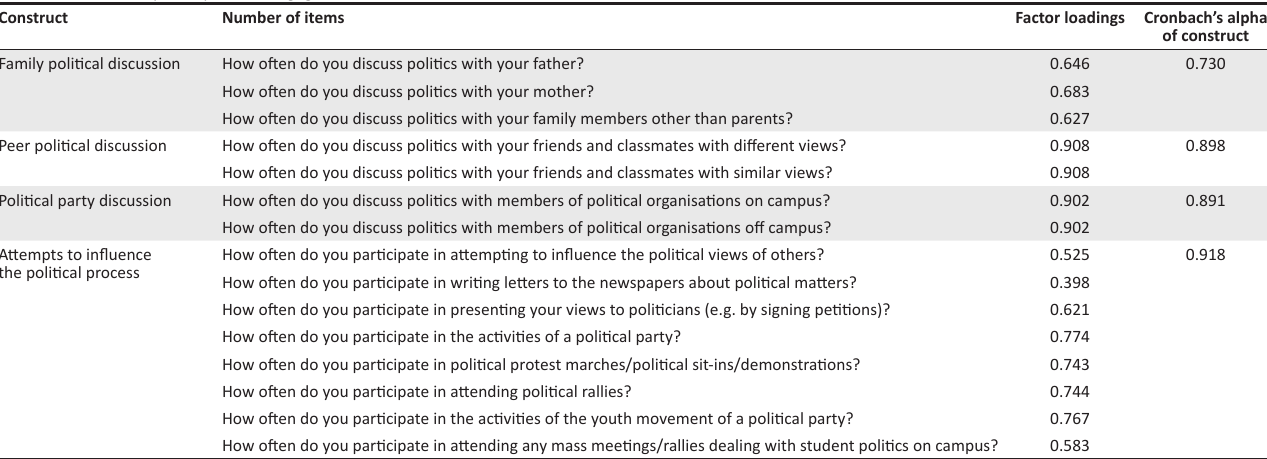
TABLE 1: Factor analysis of political engagement